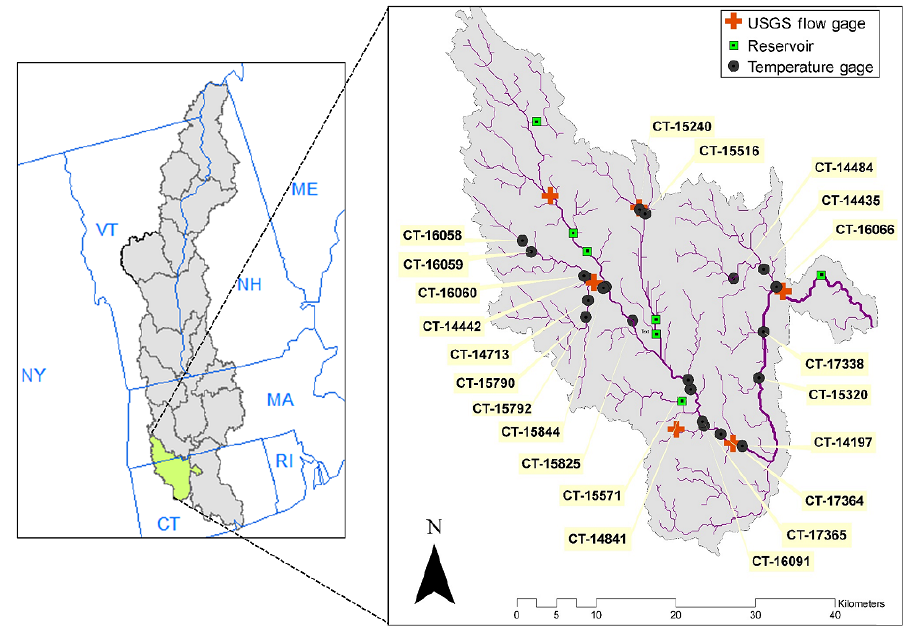
Figure 1. Map of Farmington River basin showing 22 CTDEEP water temperature monitoring sites, 6 USGS flow gage sites and 7 major reservoirs characterized by the two-layer module of